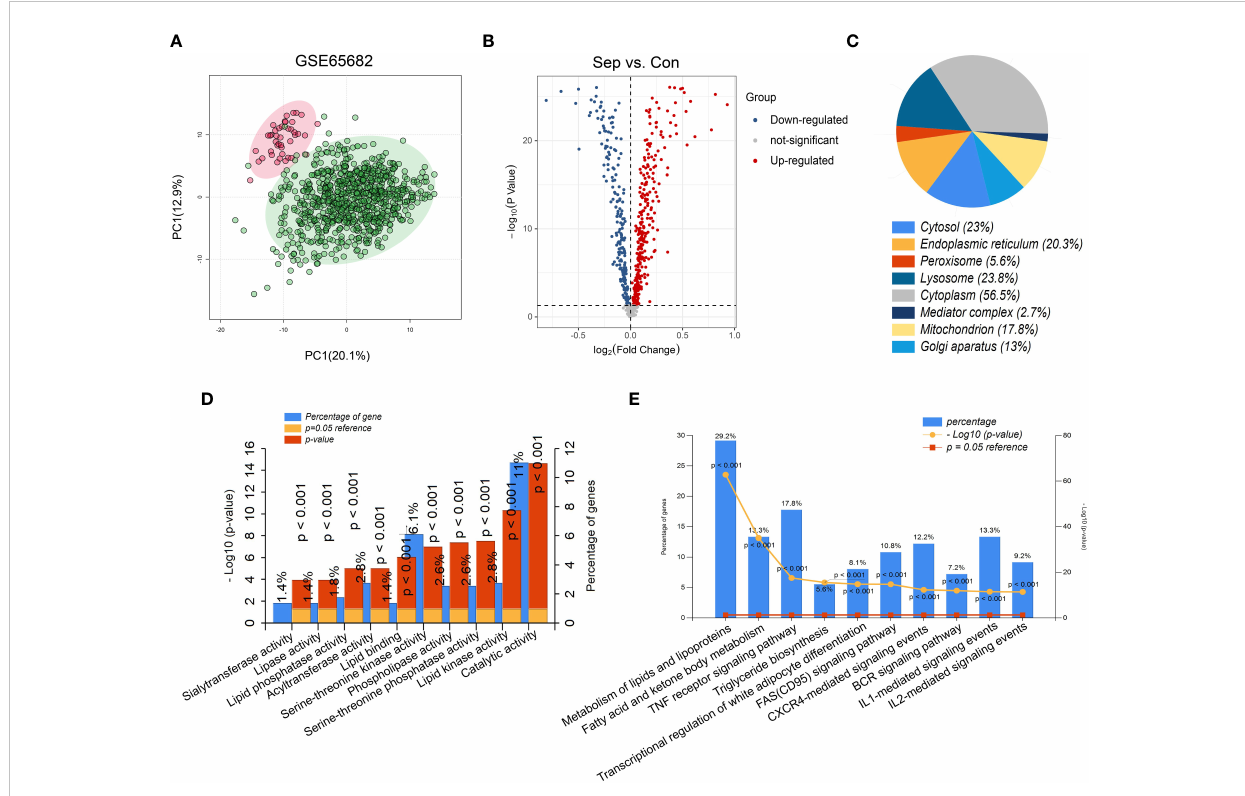
FIGURE 2 Identi fi cation of differentially expressed lipid metabolism-related genes (DE-LMRGs) from GEO dataset. (A) Principal Components Analysis (PCA) score plot of GSE65682. Each scatter represents a sample. The red represents the control group, and the green represents the sepsis group. (B) Volcano plot of DE-LMRGs in GSE65682. The blue dots indicate down-regulated DEGs while the red dots indicate up-regulated DEGs. Statistically signi fi cant DEGs were identi fi ed as those with a student ’ s t-test P < 0.05 and a fold-change > 1. Cellular compound (C) , Molecular function (D) and Biological Pathway (E) of DE-LMRGs analyzed by